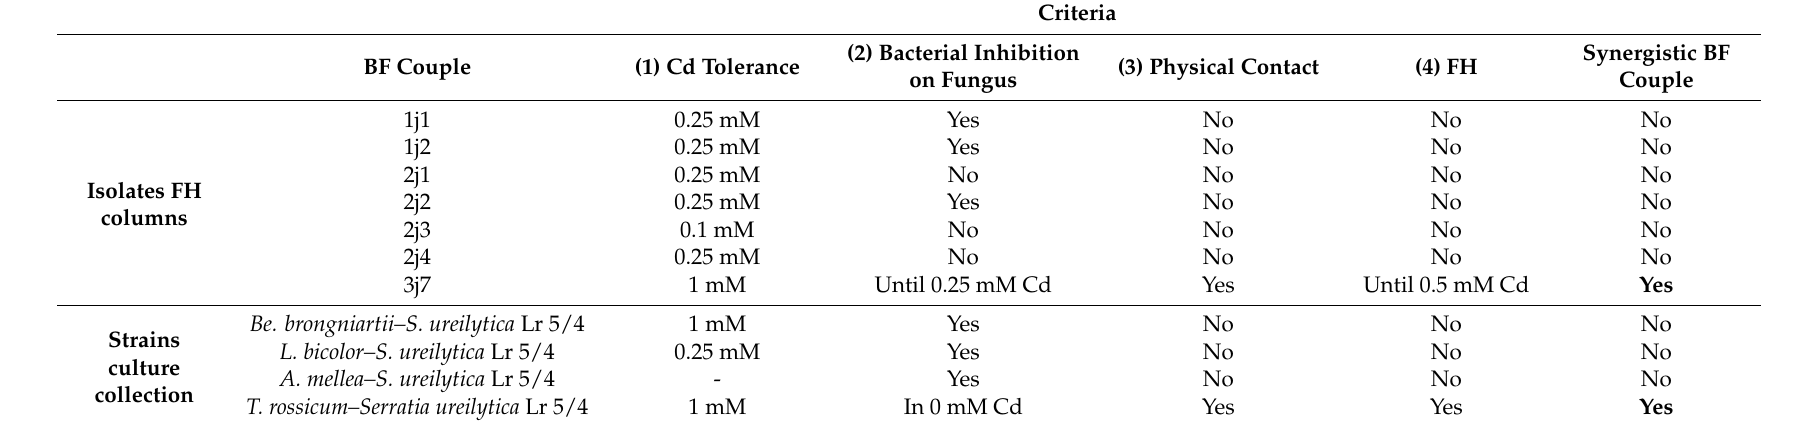
Table 2. Results of the screening to define synergistic bacterial-fungal (BF) couples using bacterial and fungal strains isolated in the field or from the culture collection. Four criteria were assessed: (1) level of Cd tolerance; (2) Bacterial inhibition on fungus; (3) Presence of a physical contact between the fungus and the bacteria; and (4) establishment of fungal highways